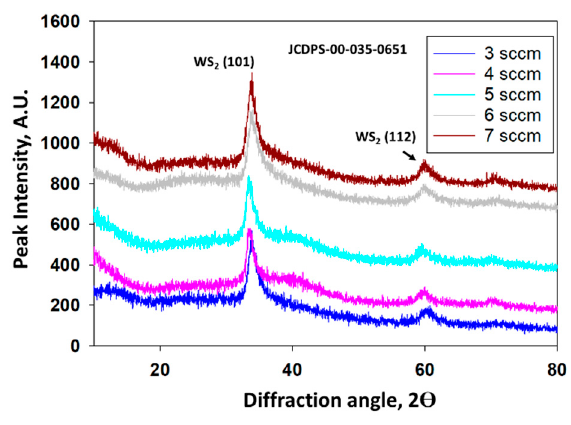
Figure 2. XRD patterns of WS 2 under different gas flow